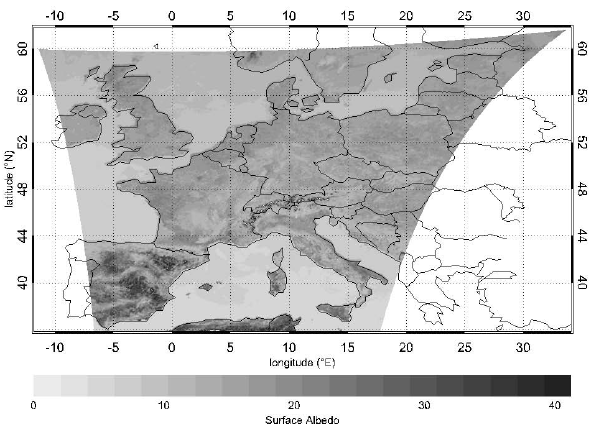
Fig. 1. Background surface albedo ( A in %) for June 2006 from minimum value compositing method. Region with high background surface albedo are shown in darker shade whereas lighter shade shows the region with low background surface